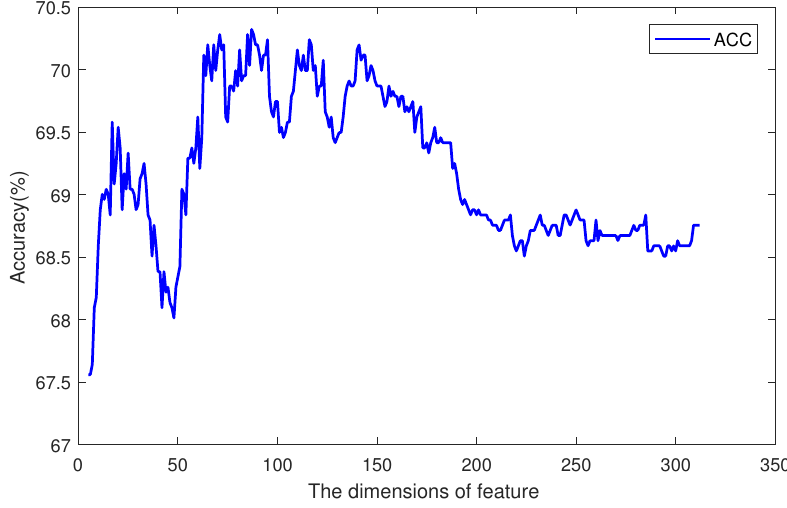
Figure 6. The tendency of accuracy on DWT